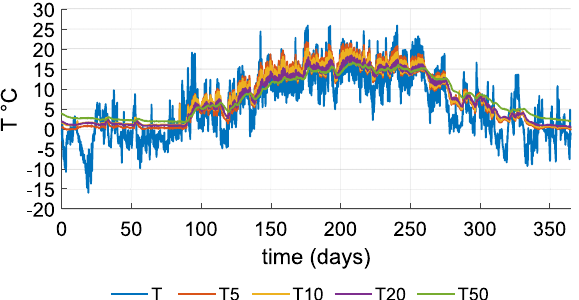
Figure 11. Input data: T is air temperature, T5 is soil temperature at 5cm, T10 is soil temperature at 10cm, T20 is soil temperature at 20cm and T50 is soil temperature at